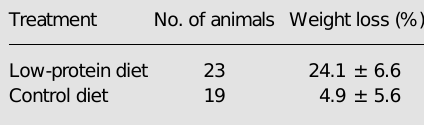
teins obtained from control (C) and under- nourished (U) mice. Each SDS-PAGE lane was loaded with 45 µg of protein obtained from bone marrow ECM (control or under- nourished). After running, the bands were stained and measured and molecular mass determined. We observed differences in both groups. A similar profile was obtained in five different experiments done with the same ECM pool (control and undernour- ished). We tested three different groups of control and undernourished mice with simi- lar results. SD, Standard molecular